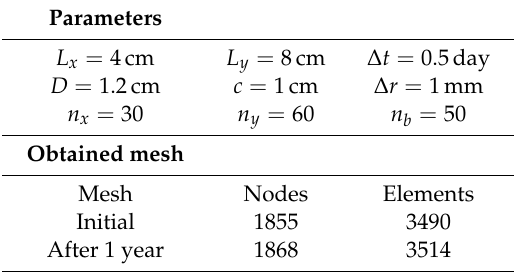
Table 2. Parameters used to define mesh and size of the obtained